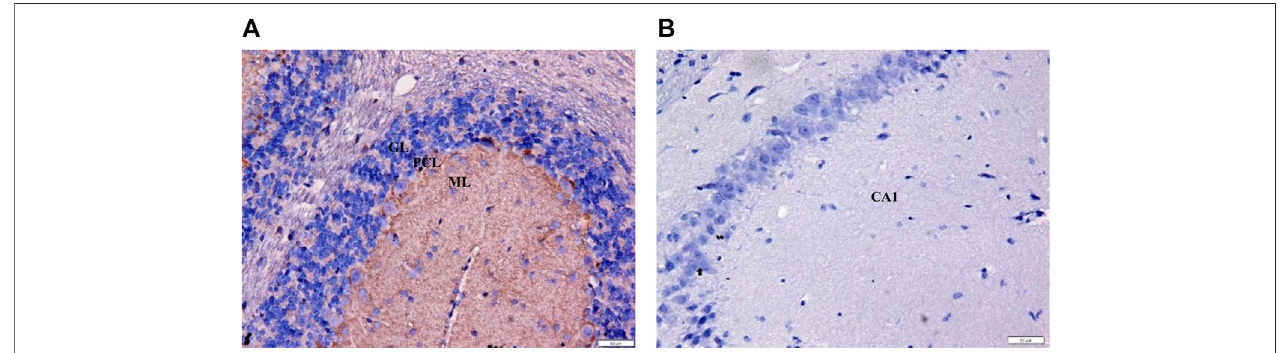
FIGURE 5 | Immunohistochemistry of positive and negative controls at × 400 magni fi cation to validate staining speci fi city. (A) Immunoreactive fi bers within the mouse cerebellar molecular layer served as the positive control for CB 1 receptor. The brown deposits con fi rm the presence of CB 1 receptors (OD (cid:1) 0.28). (B) No stain was detected in the neurons and surrounding fi bers of the CA1 hippocampal region (negative control; OD (cid:1) 0.00). GL (cid:1) granular layer; PCL (cid:1) Purkinje cell layer; ML (cid:1) molecular layer; Bars (cid:1) 50 µm.